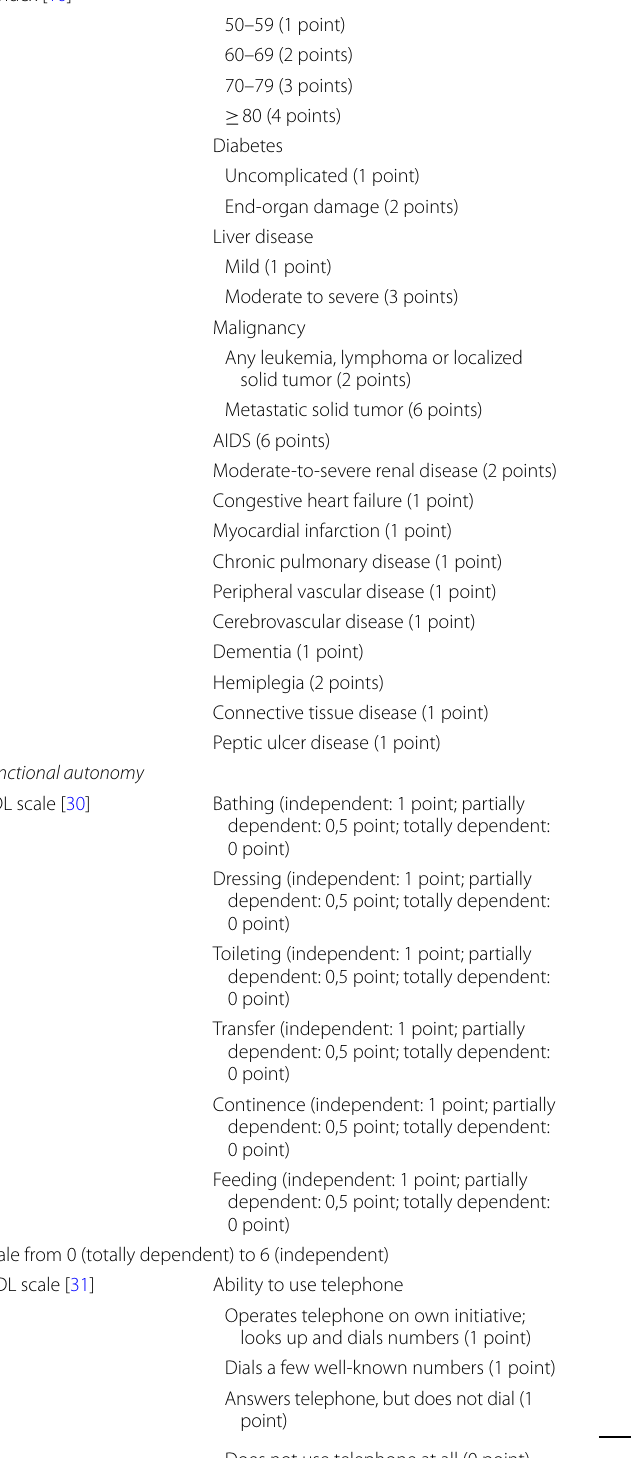
Table 1 Summary of main scales used in geriatric evaluation Comorbidities Charlson comorbidity index